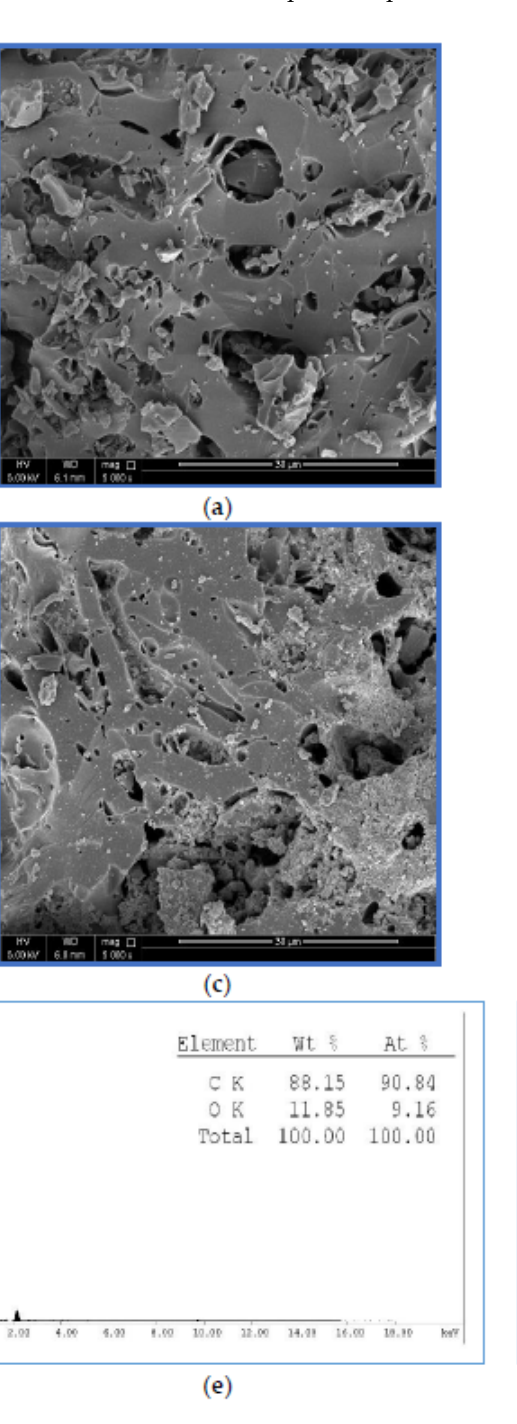
Figure 5. SEM micrographs of ( a , b ) OSBC, ( c , d ) MAG–OSBC at 5000 × and 10,000 × magnifications, ( e , f ) EDX analyses of OSBC and MAG–OSBC,